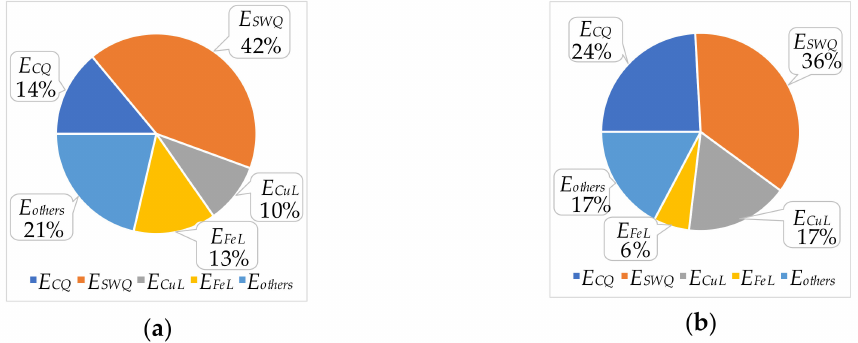
Figure 9. Loss distribution diagram of 3-pin all-SiC MOSFET PWM rectifier: ( a ) Half-load 15 kW ( E tot / P ≈ 2.2%), ( b ) Full-load 30 kW ( E tot / P ≈ 2.6%).